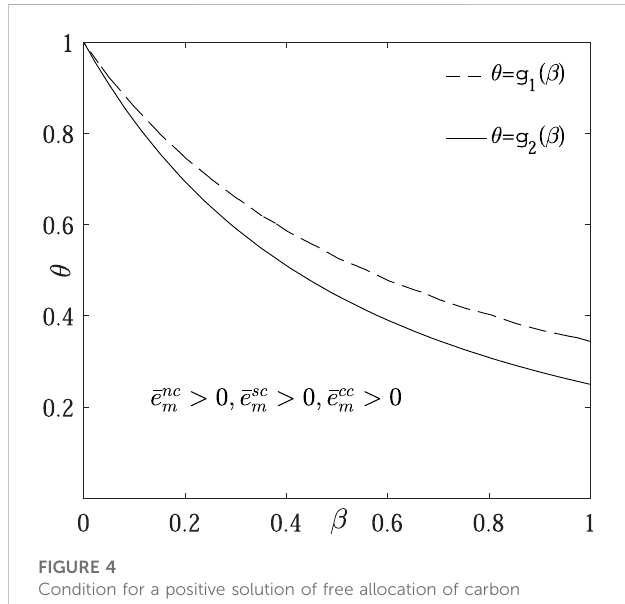
FIGURE 4 Condition for a positive solution of free allocation of carbon allowance under each